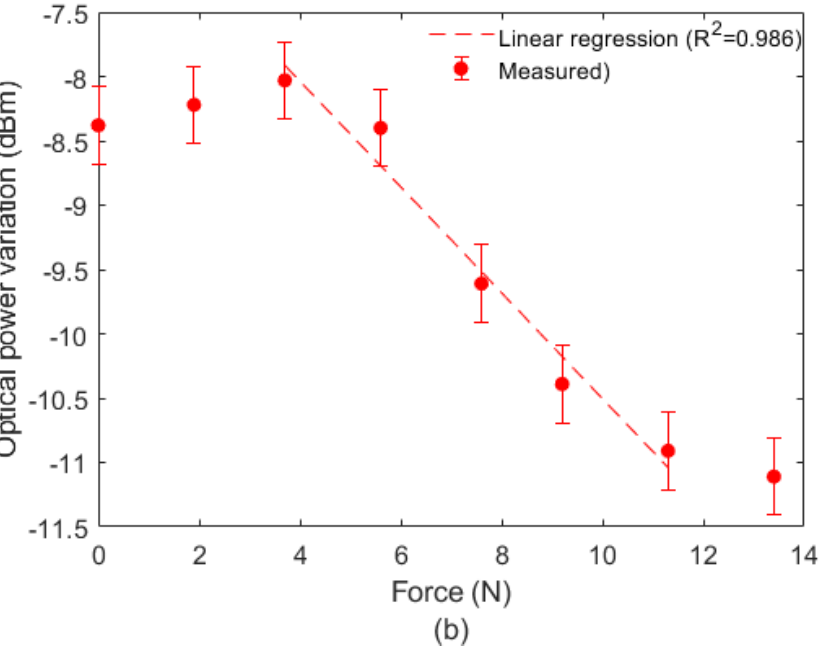
Figure 5. Reflected optical power variation as a function of ( a ) displacement and ( b ) force. Similarly, as shown in Figure 5a,b, the reflected optical power also presented differ- ent sensitivities to displacement and force, where −3.3 dBm/mm and −0.41 dBm/N were estimated for displacement and force, respectively. However, the optical power variation presented a linear response only in a limited range between around 2.0 mm and 2.8 mm